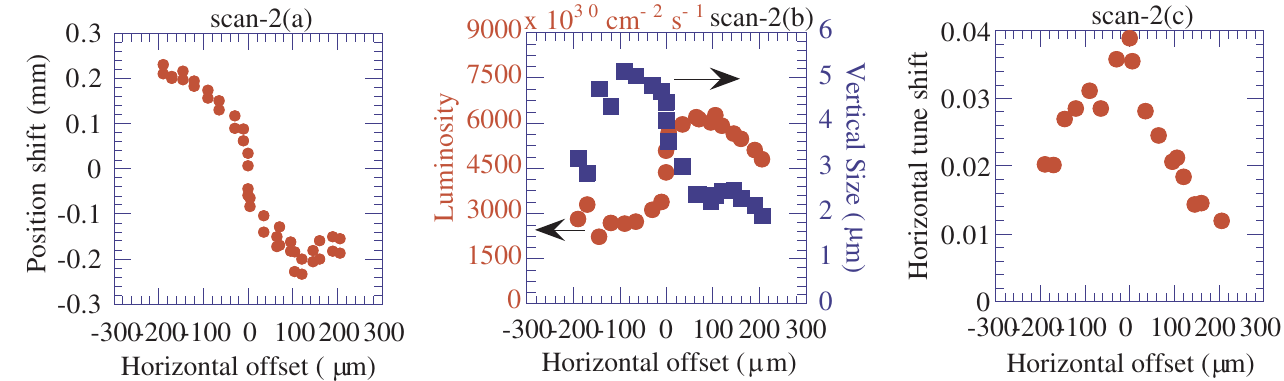
FIG. 7. (Color) Variations of the beam parameters as a function of the horizontal offset with the beam condition of scan-2 (relatively high current). Position shift at LER-2 (a), luminosity (red dots) and vertical beam size of the positron beam at the IP (blue squares) (b), and horizontal beam-beam tune shift (c).